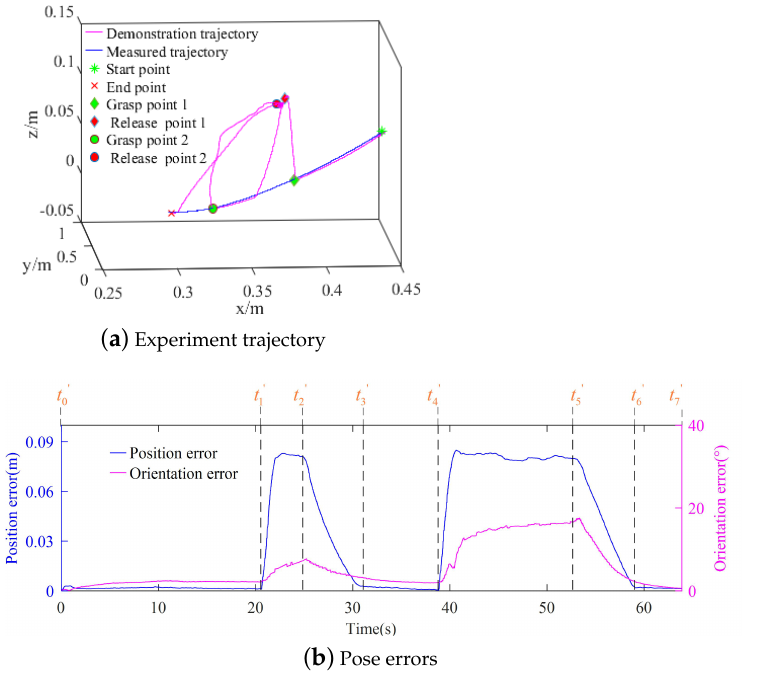
Figure 16. Experiment trajectory and pose errors under motion modeled by DMP and interactions.